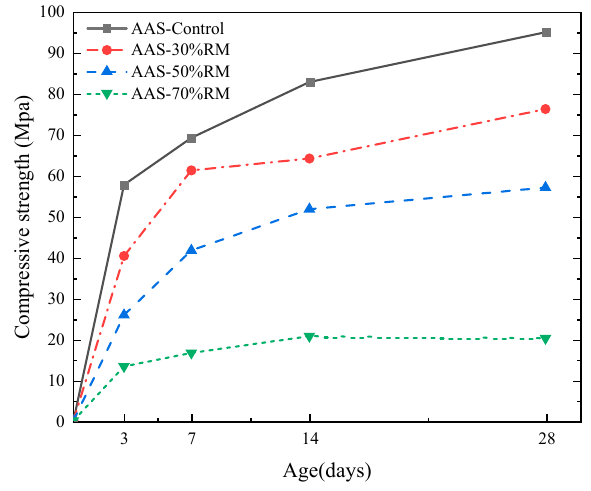
Figure 3. Compressive strength of AASR.